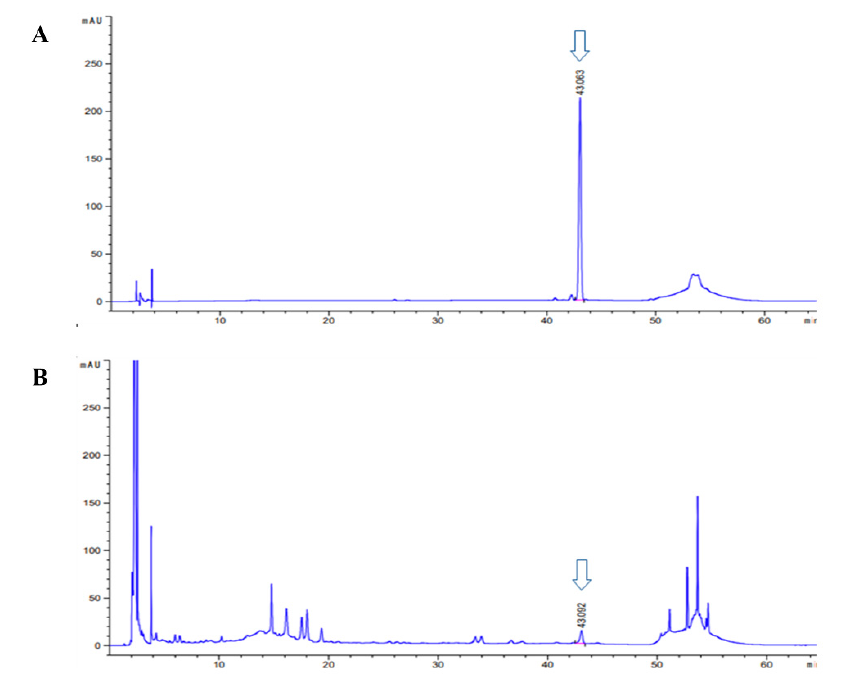
Figure 5. High-performance liquid chromatography (HPLC-PDA) chromatogram of asiaticoside and CA-HE50. HPLC chromatogram of: ( A ) asiaticoside (standard); and ( B ) CA-HE50.